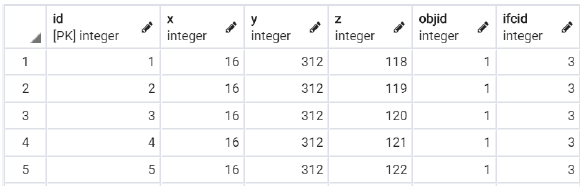
Table 2. Code list of IFC attribute (26 in total).